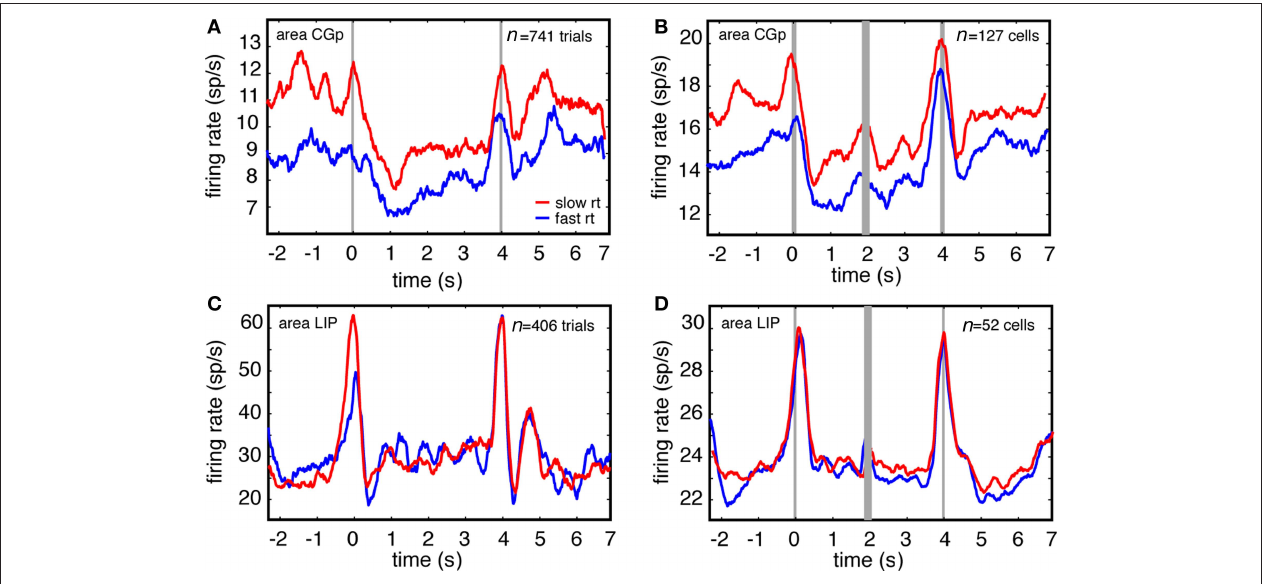
of CGp neurons on fast and slow reaction time trials immediately following switches. Responses are separately aligned to trial onset (time = 0) and trial offset (time = 4). (C) Responses of example LIP neuron on fast and slow reaction time trials immediately following task switches. (D) Responses of population of LIP neurons on fast and slow reaction time trials immediately following task